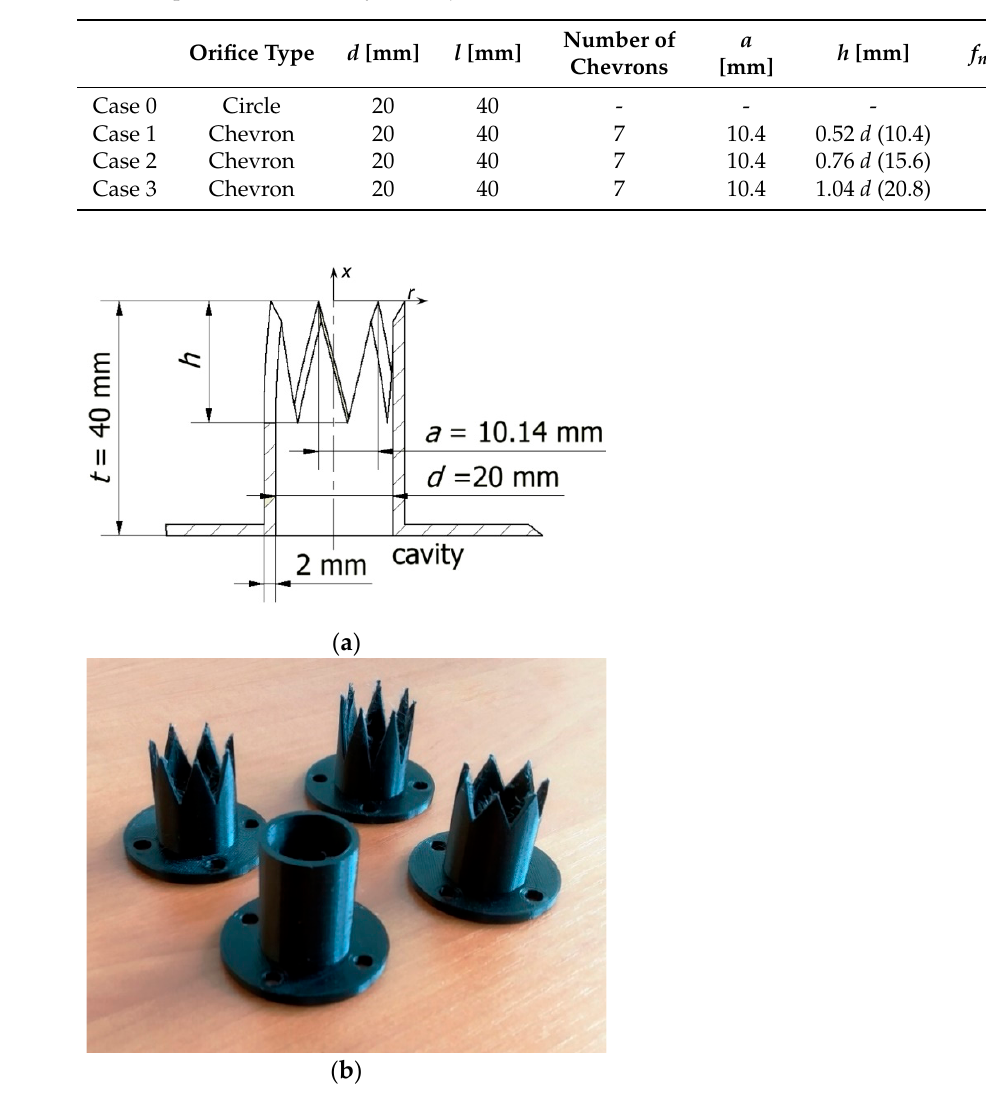
Table 1. Specification of the synthetic jet actuators (SJAs).